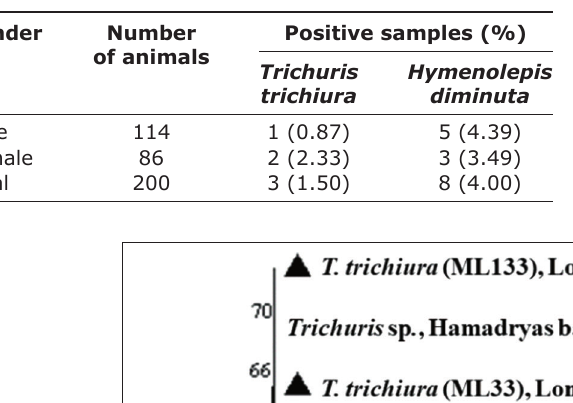
Table-1: Trichuris trichiura and Hymenolepis diminuta infection in long-tailed macaques ( Macaca fascicularis ).